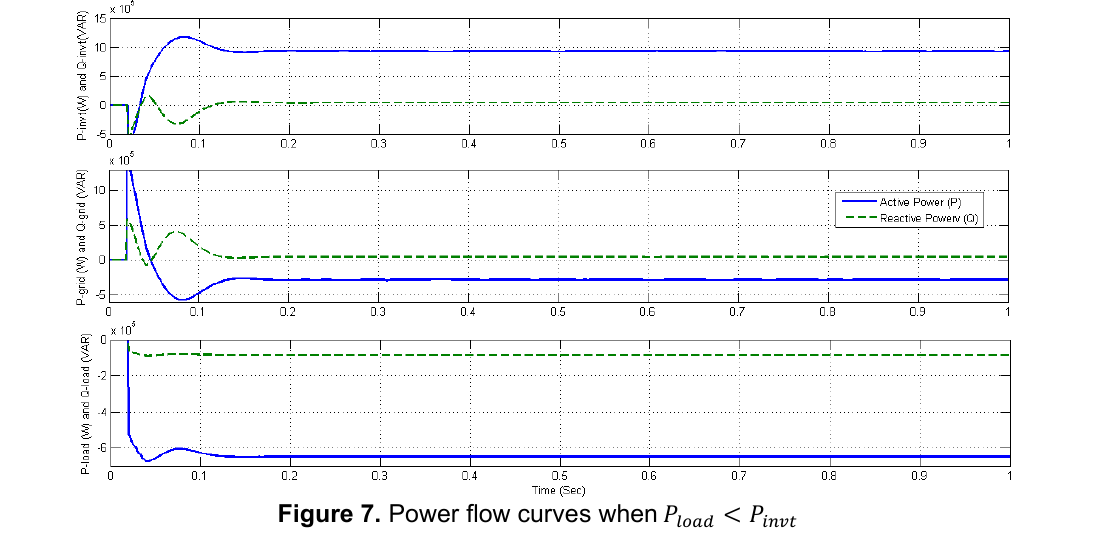
Figure 7. Power flow curves when